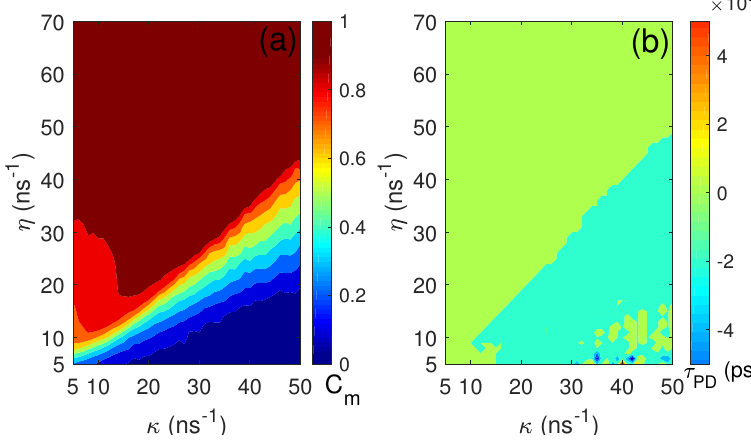
Figure 8. Mapping of C m ( a ) and the corresponding τ PD ( b ), in the plane of κ and η for keeping other parameters as J m = 1.10 I th , J R = 1.08 I th , τ ext = 10 ns, τ f = 0, and ∆ f =